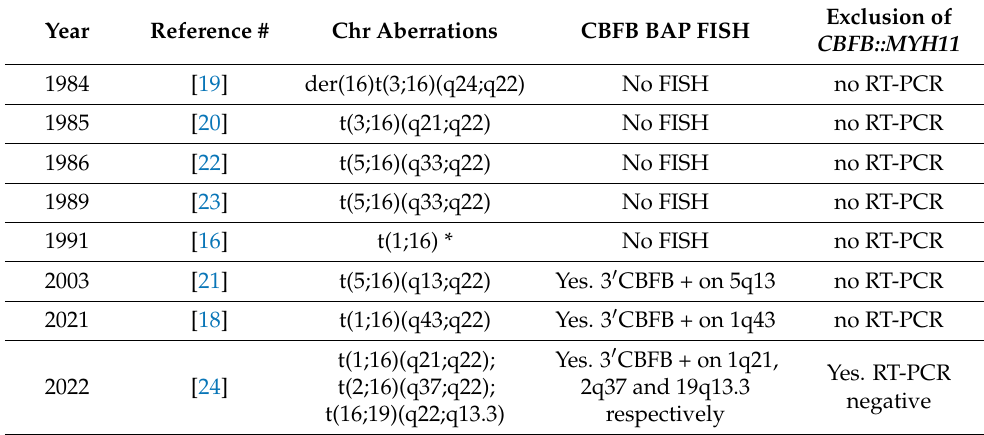
Table 1. Case with potential novel partners for CBFB rearrangement reported in the